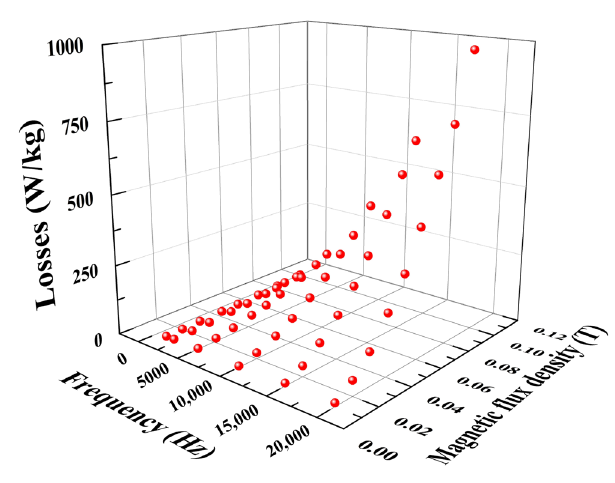
Figure 3. Losses at different frequencies and magnetic-flux densities.